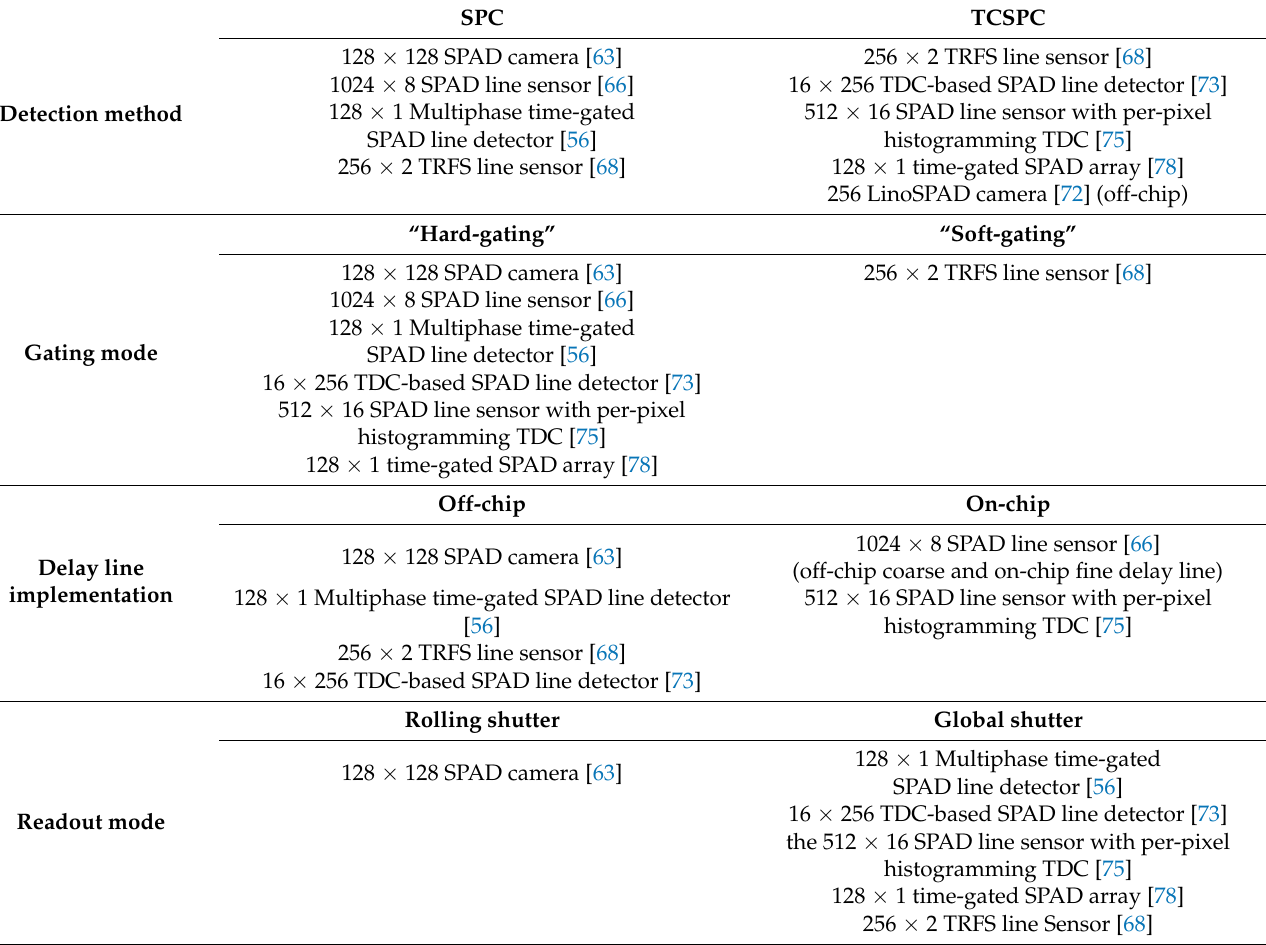
Table 1. Comparison of SPAD arrays presented in Section 4, in terms of detection method, gating mode, delay line implementation, and readout